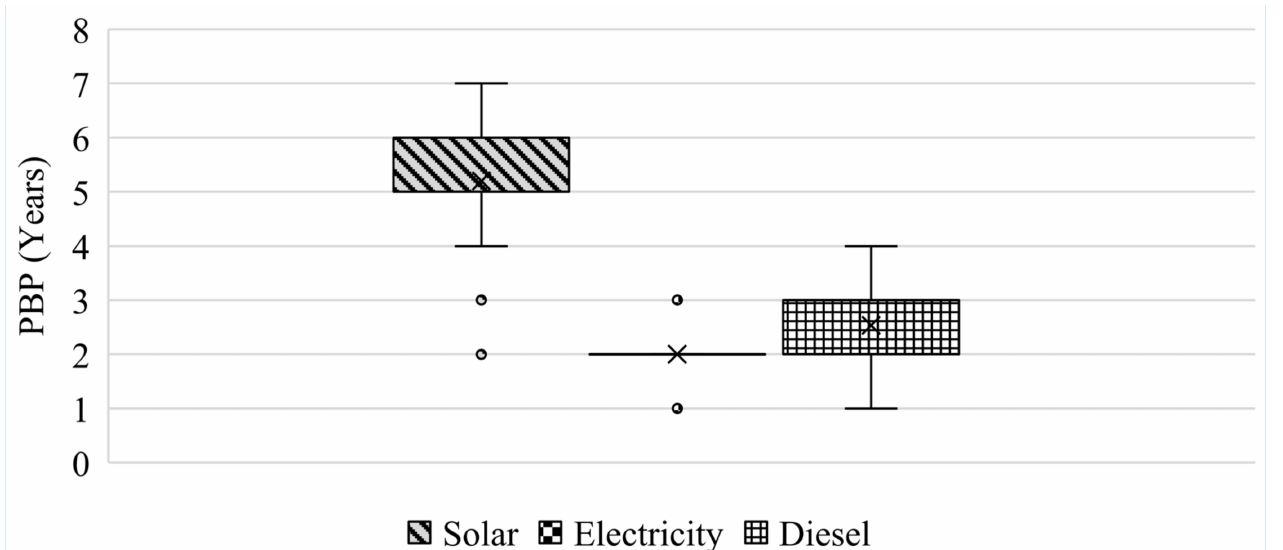
Figure 8. PBP of different power sources for DIS.